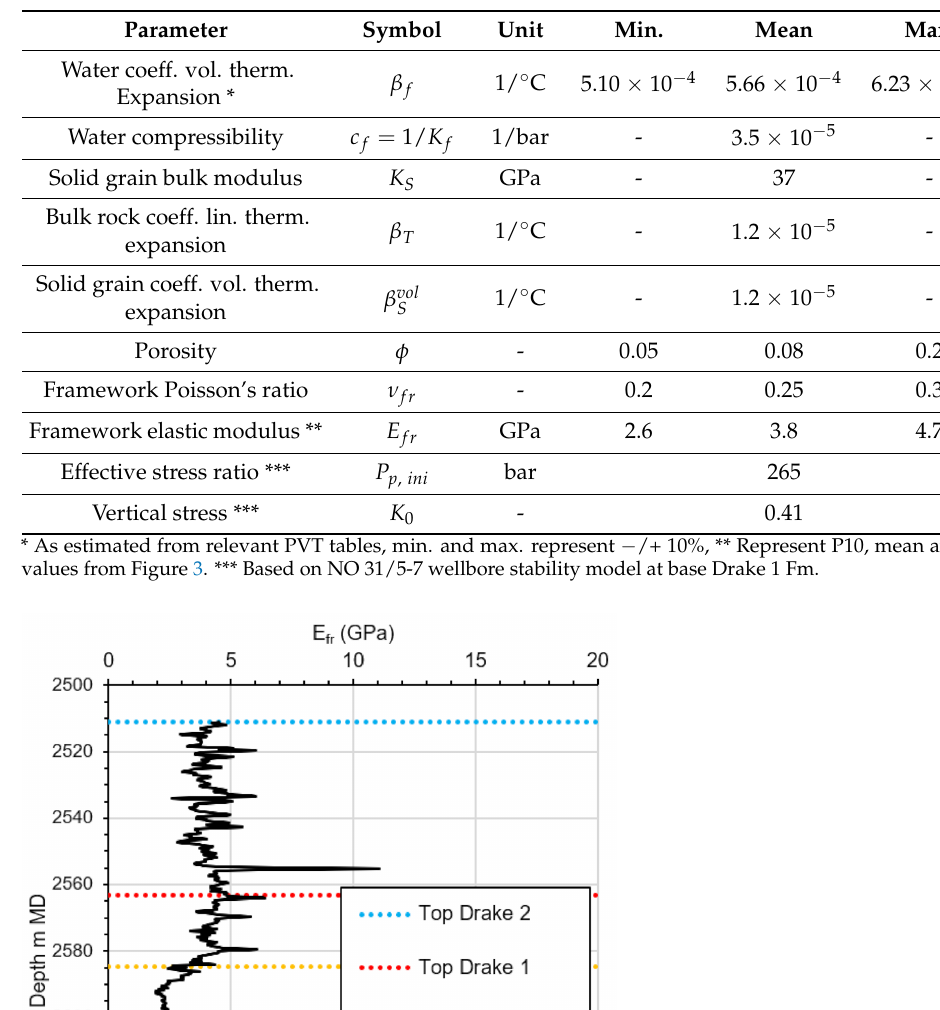
Table 1. Parameter value assumptions.